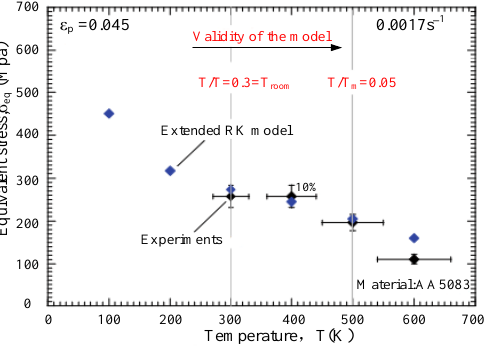
Figure 20. Temperature sensitivity description using the extended RK model [45].